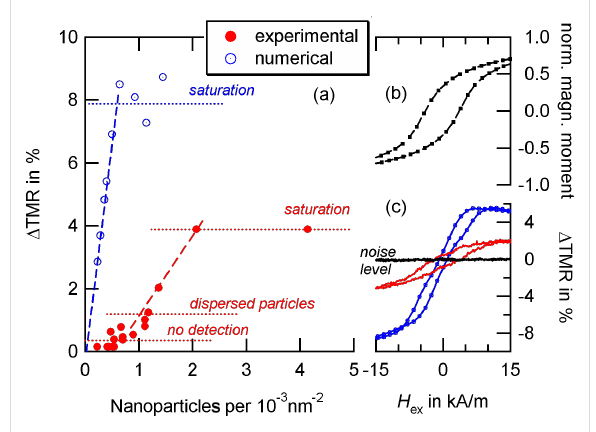
Figure 13: Properties of the magnetoresistive sensors. (a) Compari- son between experimental and numerical data. The magnetic prop- erties of the 14 nm Co particles obtained by AGM measurements (b). The coercive field H C = 3.76 kA/m entails a hysteretic Δ TMR-signal (c) due to the detection of nanoparticles that interact by dipolar